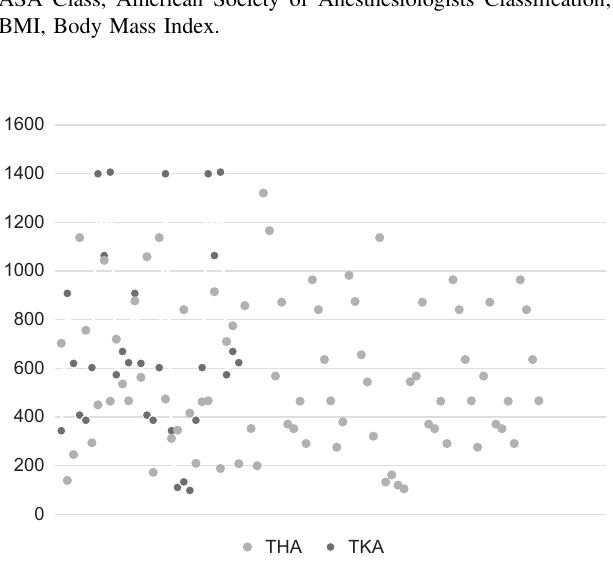
HIV – ve, HIV negative; HIV +ve, HIV positive; N/A, Not Available (unknown HIV status); ASA Class, American Society of Anesthesiologists Classi fi cation; BMI, Body Mass Index.